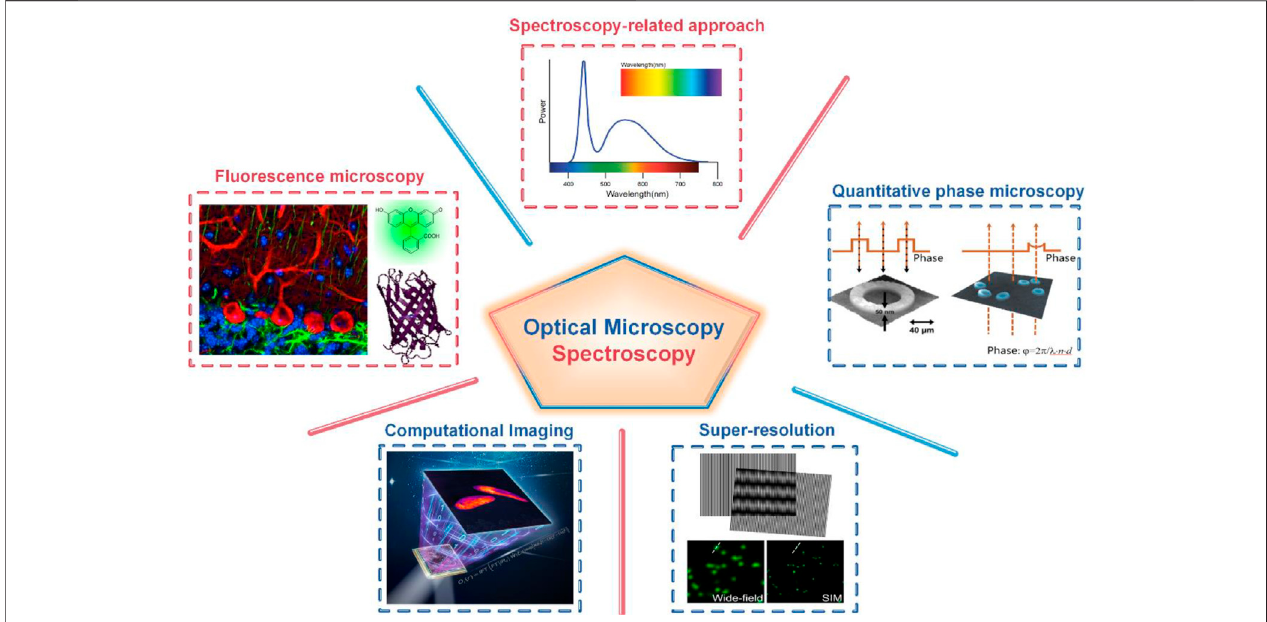
FIGURE 1 | Topical classi fi cation of the articles in the special issue